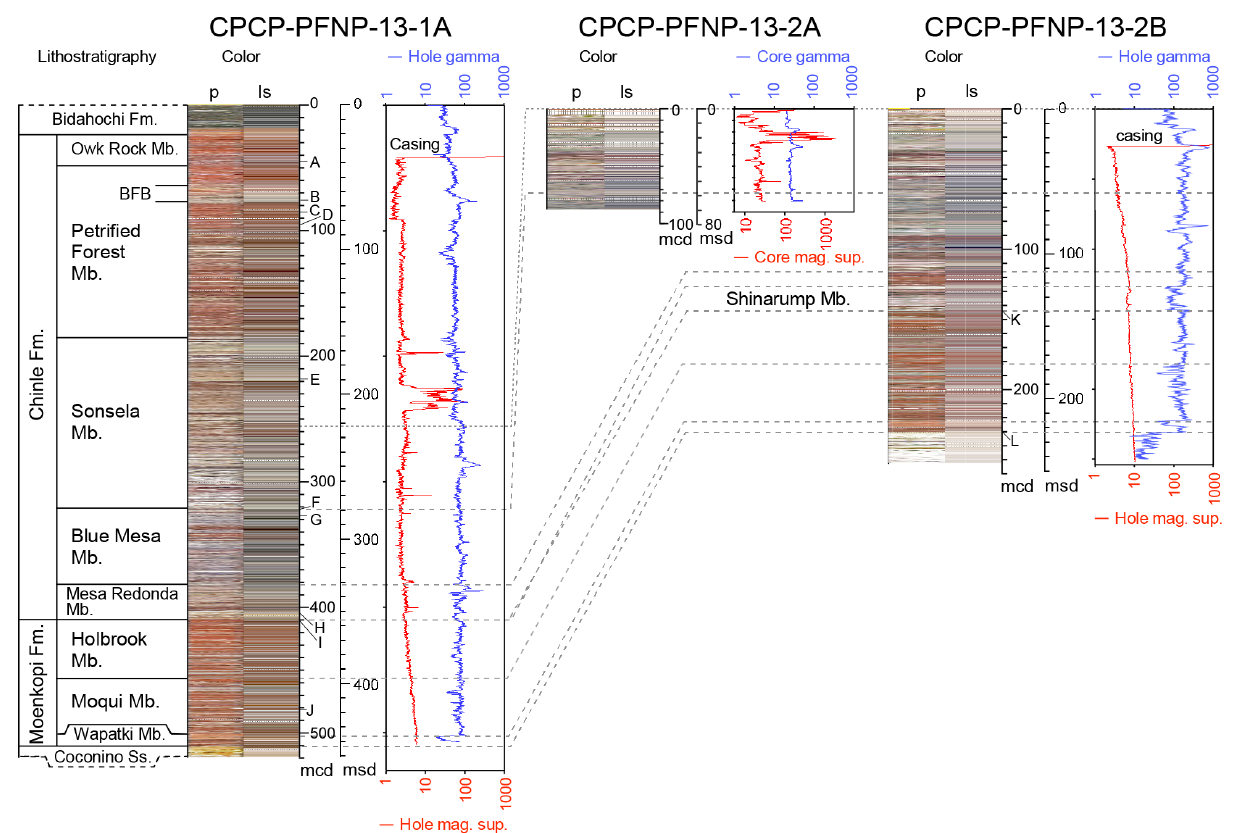
Figure 6. Lithologic logs, compressed photographs (p), line-scan images (ls), natural gamma, and magnetic susceptibility, for each of the cores and holes drilled during the CPCP. Letters A–K refer to core segment photographs in Fig. 8. Abbreviations for the core depths are mcd, meters core (or hole) depth; msd, meters stratigraphic depth of a core or hole with msd = 0.866 · mcd in 1A, msd = 0.858 · mcd in 2A, and msd = 0.969 · mcd in